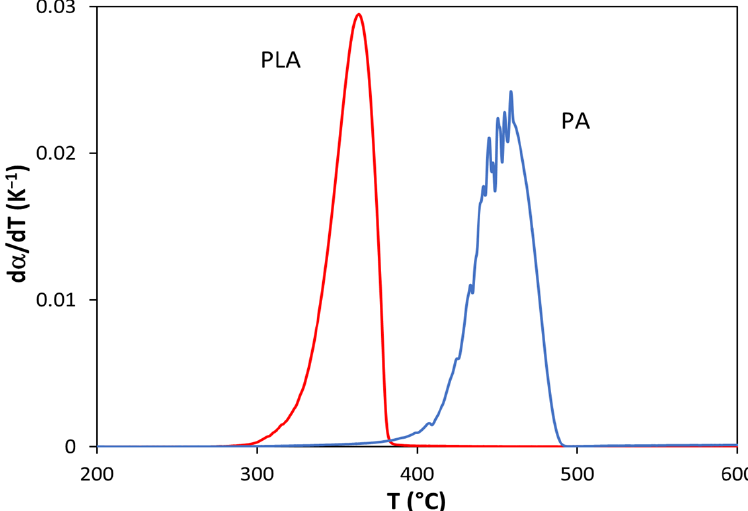
Figure 2. Variation in the conversion derivative of PLA and PA as a function of temperature (nominal heating rate = 10 K/min).